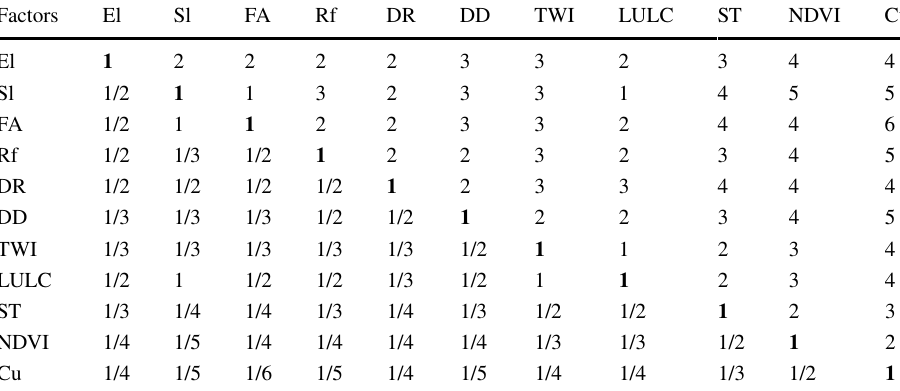
Table 3 Pairwise comparison matrix for selected flood- controlling factors